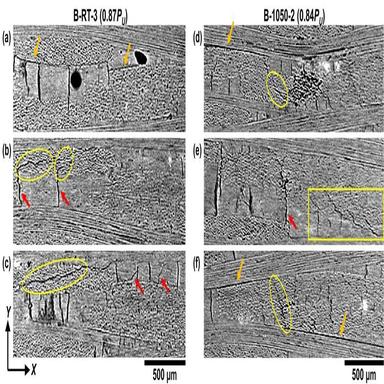
(a)-(c) Fracture patterns in material B at RT (specimen B-RT-3) and (d)-(f) at 1050 C (B-1050-2). Orange arrows indicate Type I interfacial cracks; yellow circles Type II inclined intra-tow cracks; red arrows Type III matrix cracks, and yellow rectangle microcracks (parallel cracks or bifurcation). Note: the area investigated for B-RT-3 was located near the compression side of the specimen on the left-hand side of the DVC field of view presented in For B-1050-2, the area was in the middle of the